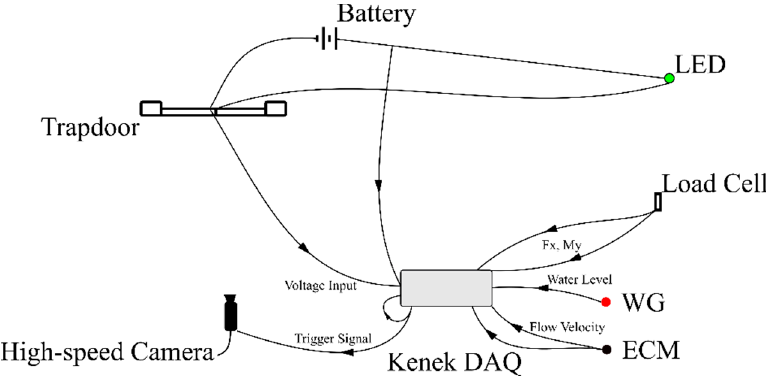
Figure 3. Data Acquisition (DAQ) system setup for the experimental setup.